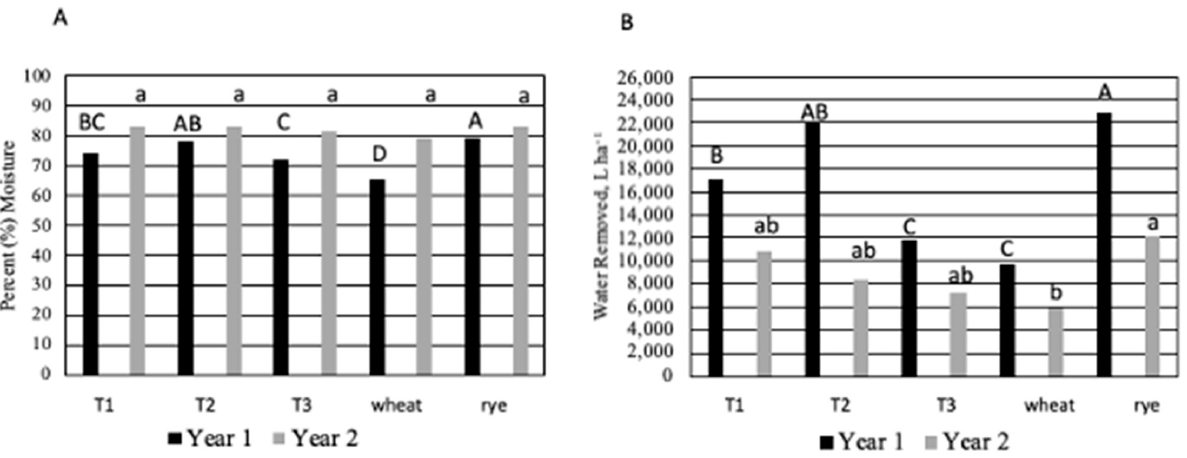
Figure 5. ( A ) Percent moisture of DPCCs in each experimental year. ( B ) Water removed by DPCCs during each experimental year. Means separated by Tukey’s HSD range test. Within the same row, values followed by different letters are statistically different. Uppercase letters are associated with values in year 1; lowercase letters are associated with values in year 2.